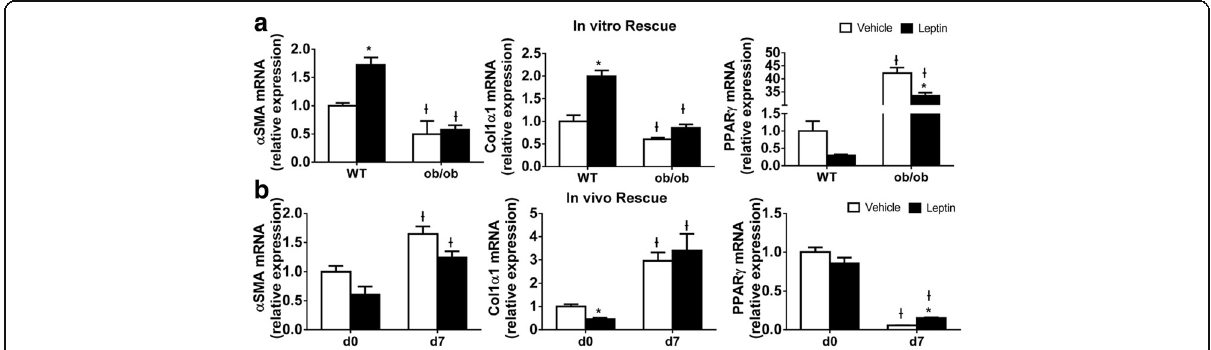
Fig. 5 Leptin Treatment Does Not Rescue Leptin-deficient HSCs ( a ) Primary HSCs isolated from either WT or ob/ob mice were cultured in serum-containing medium and treated with leptin (100 ng/ml) or vehicle for 3 days. RNA was isolated, and changes in gene expression of MF markers were evaluated by qRT-PCR. Results were normalized to WT HSCs treated with vehicle. Ɨ p <0.05 vs WT, * p <0.05 vs vehicle. b Leptin or vehicle was administrated subcutaneously (100 g/kg body weight per day) to ob/ob mice for 6 days. Primary HSCs were isolated and cultured for 7 days. qRT-PCR analysis of gene expression in freshly isolated and 7-day cultured HSCs. Results were normalized to d0 ob/ob HSCs treated with vehicle. Ɨ p <0.05 vs WT, * p <0.05 vs